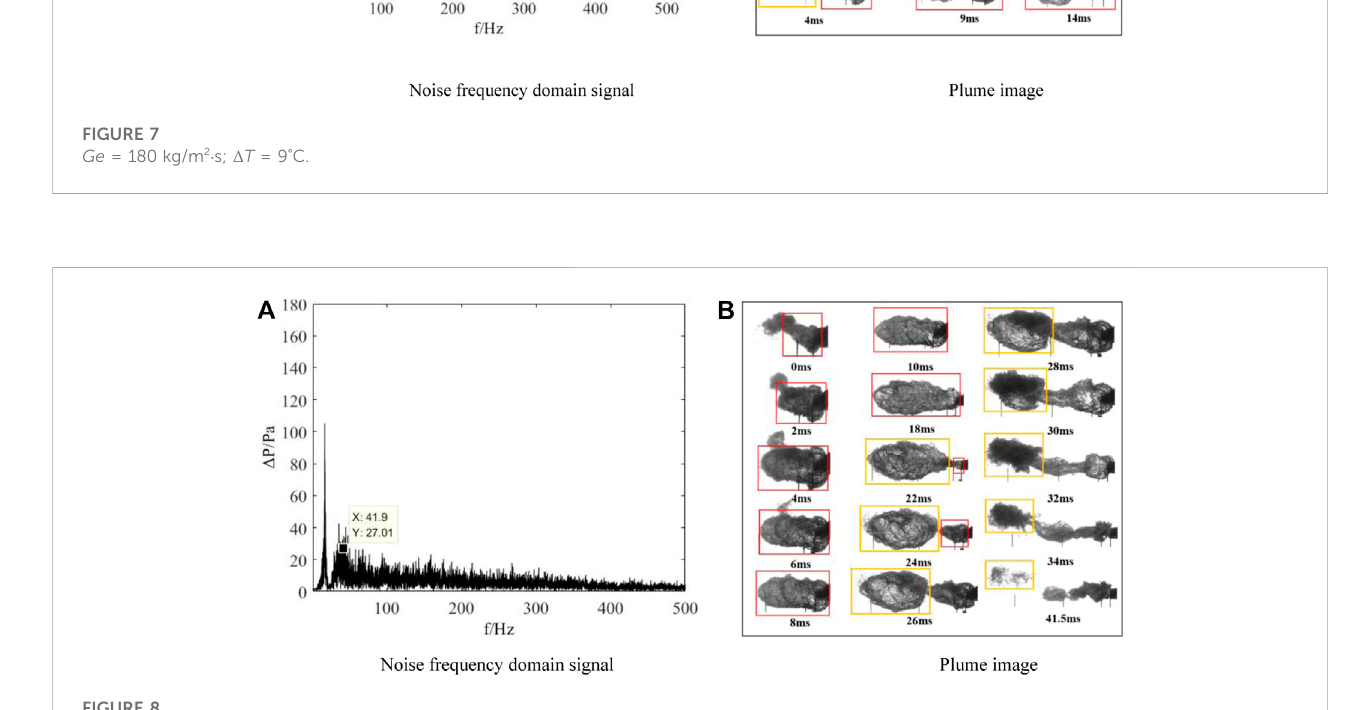
FIGURE 8 Ge = 180 kg/m 2 · s; Δ T = 7 °